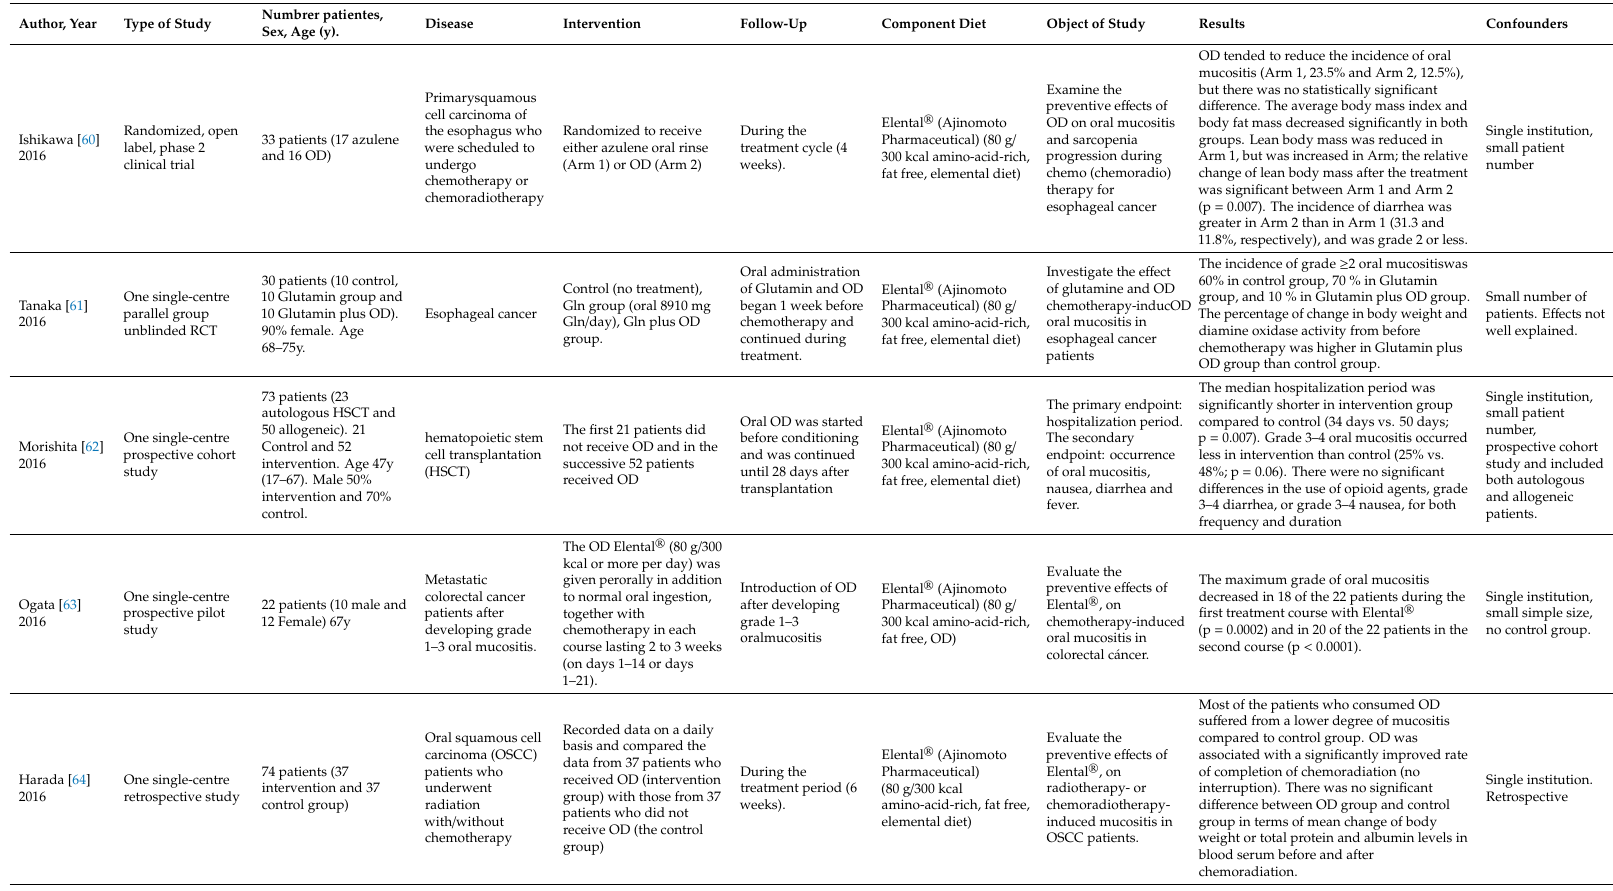
Table 3. Studies with oligomeric diet and chemotherapy-induced oro-intestinal